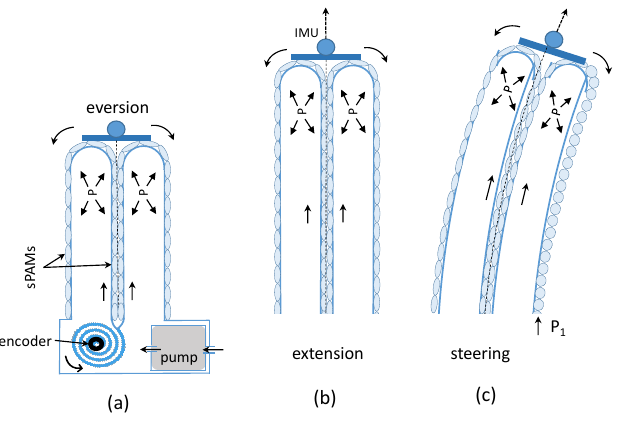
Figure 1. Working principal of the growing vine robot. ( a ) Air pressure is applied to the robot’s core tube to facilitate the tip extension in ( b ). Steering in ( c ) is carried out by varying the air pressure in one or two of the sPAMs placed around the vine